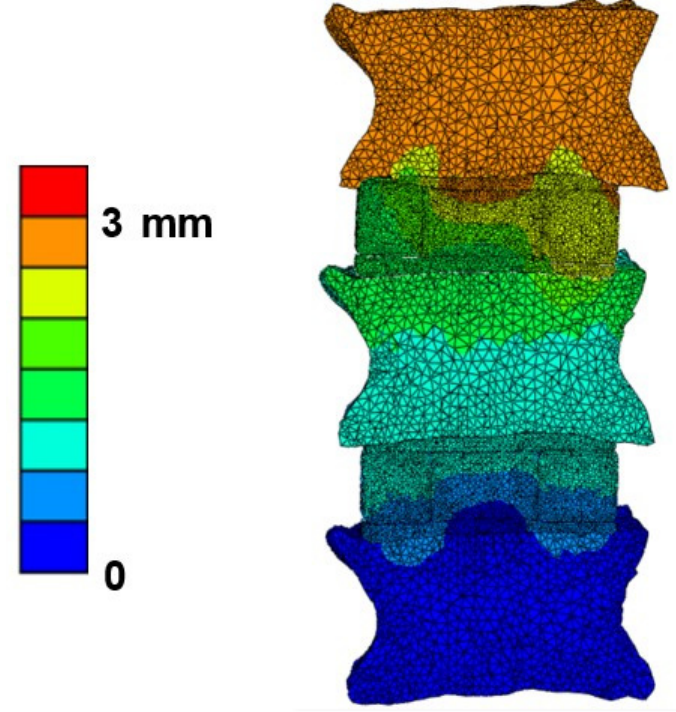
Figure 7. Cross - sectional view of vertical axial displacement distribution for the FSU model at fail- ure.